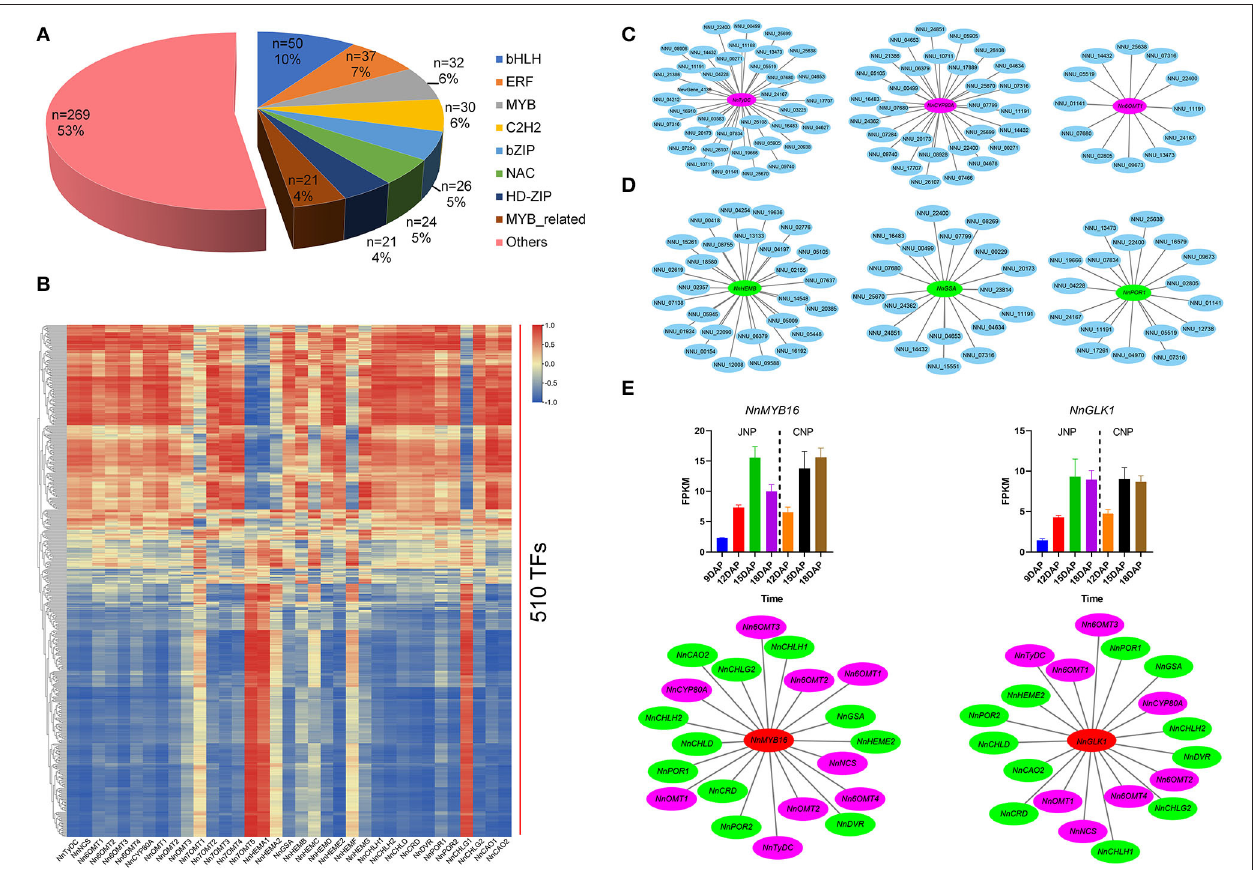
FIGURE 7 | Identification of transcription factors co-expressed with bis-BIAs and Chl biosynthesis genes. (A) The proportion of differentially expressed TFs. (B) Visual representation of the co-expression relationships between 510 TFs and bis-BIAs/ Chl biosynthesis genes. (C) Selected bis-BIAs, and (D) Chl biosynthesis genes co-expressed with TFs. (E) The FPKM expression of NnMYB16 (NNU_07316) and NnGLK1 (NNU_11191), and their co-expression with multiple bis-BIAs and Chl biosynthesis genes,